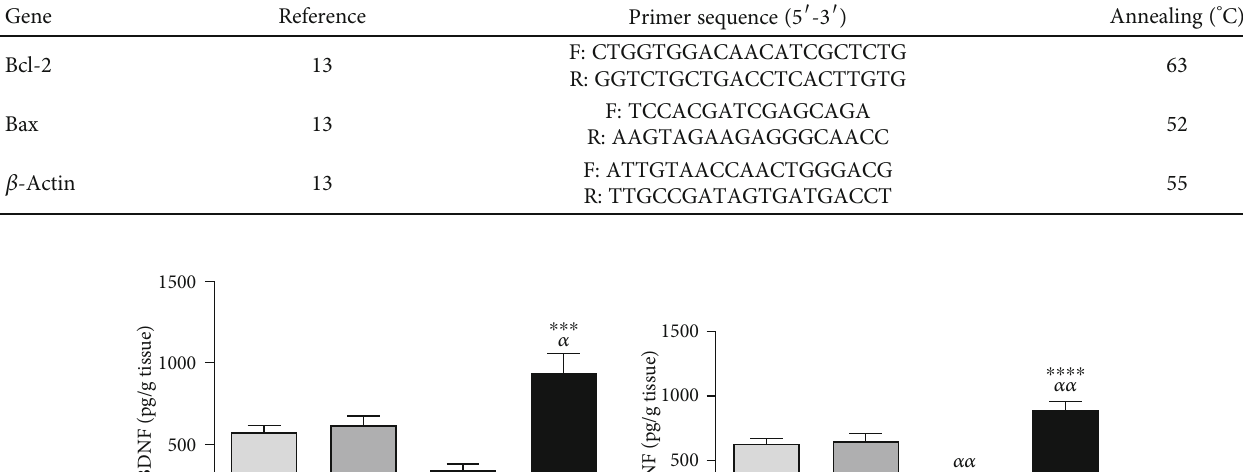
Table 1: Primer pairs and annealing temperatures for reverse transcriptase-polymerase chain reaction. Gene